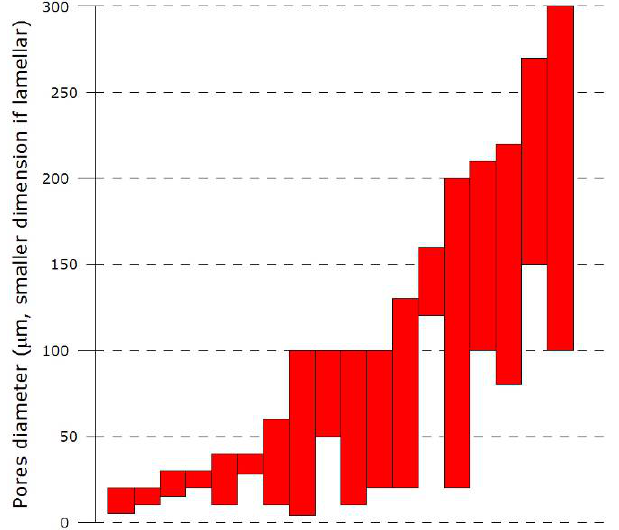
Figure 5. Measured or estimated pore channels size of freeze-cast ceramics, from reference [18–20,22,25,30,31,33,35–39,44,45,48,54,65–67]. The dimension plotted in the case of the lamellar structure corresponds to the smaller dimension of the pore, see reference [54] for further explanations. Each bar corresponds to a different study from the reference list, ranked in order of increasing maximum pore